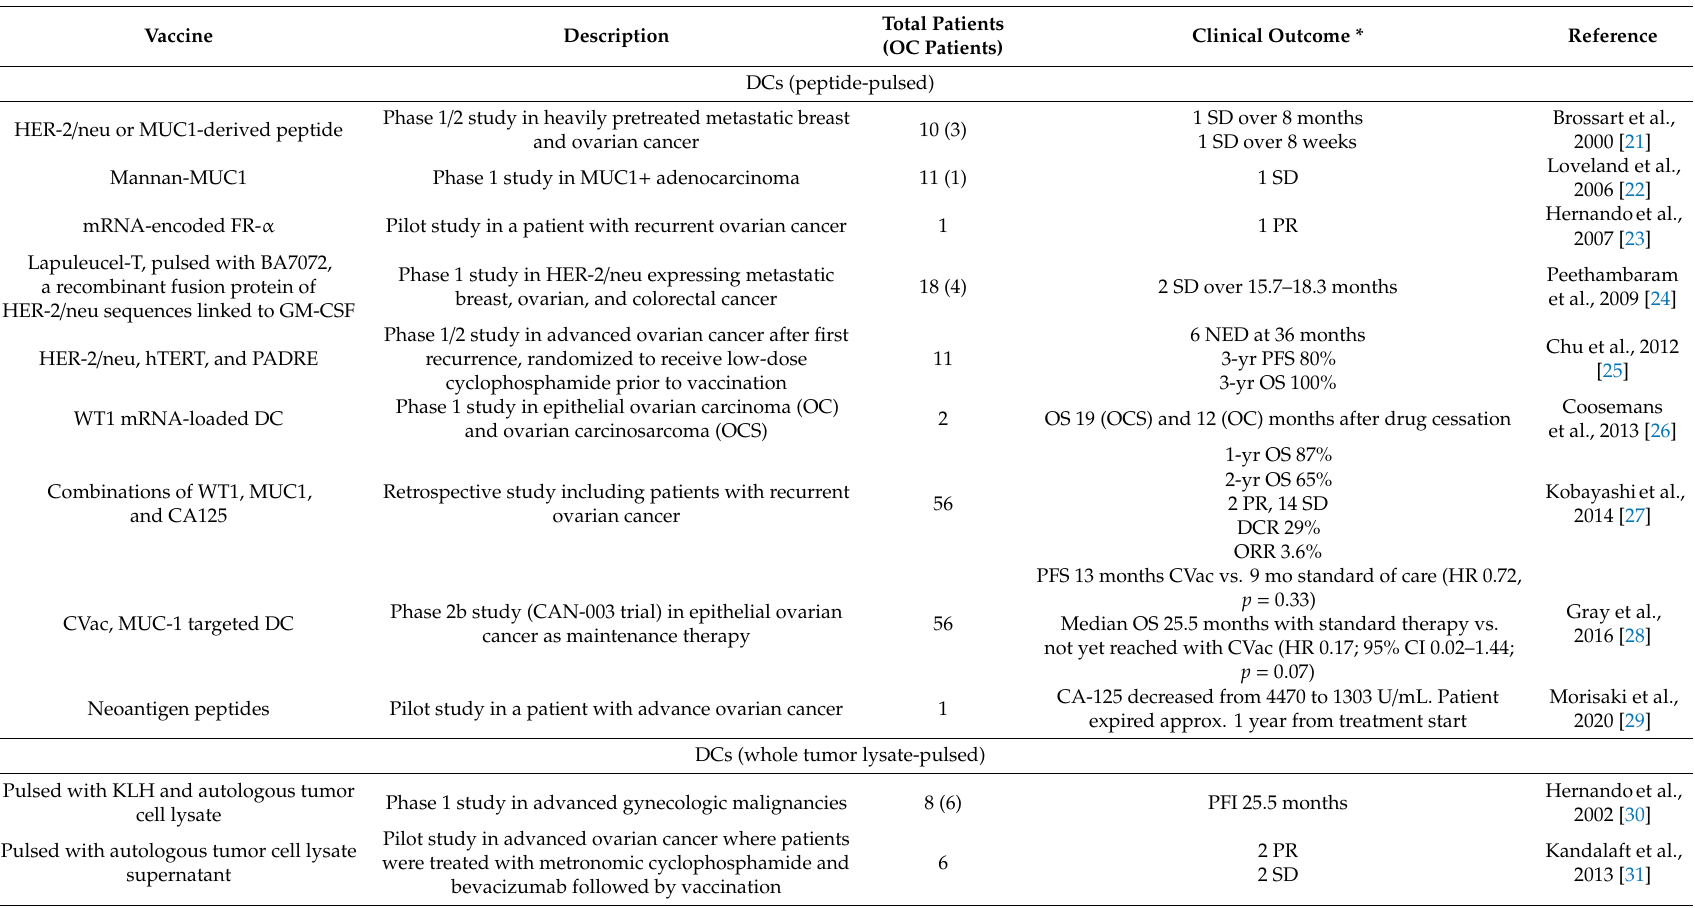
Table 1. Summary of published clinical trials on ovarian cancer vaccines with clinical outcome to